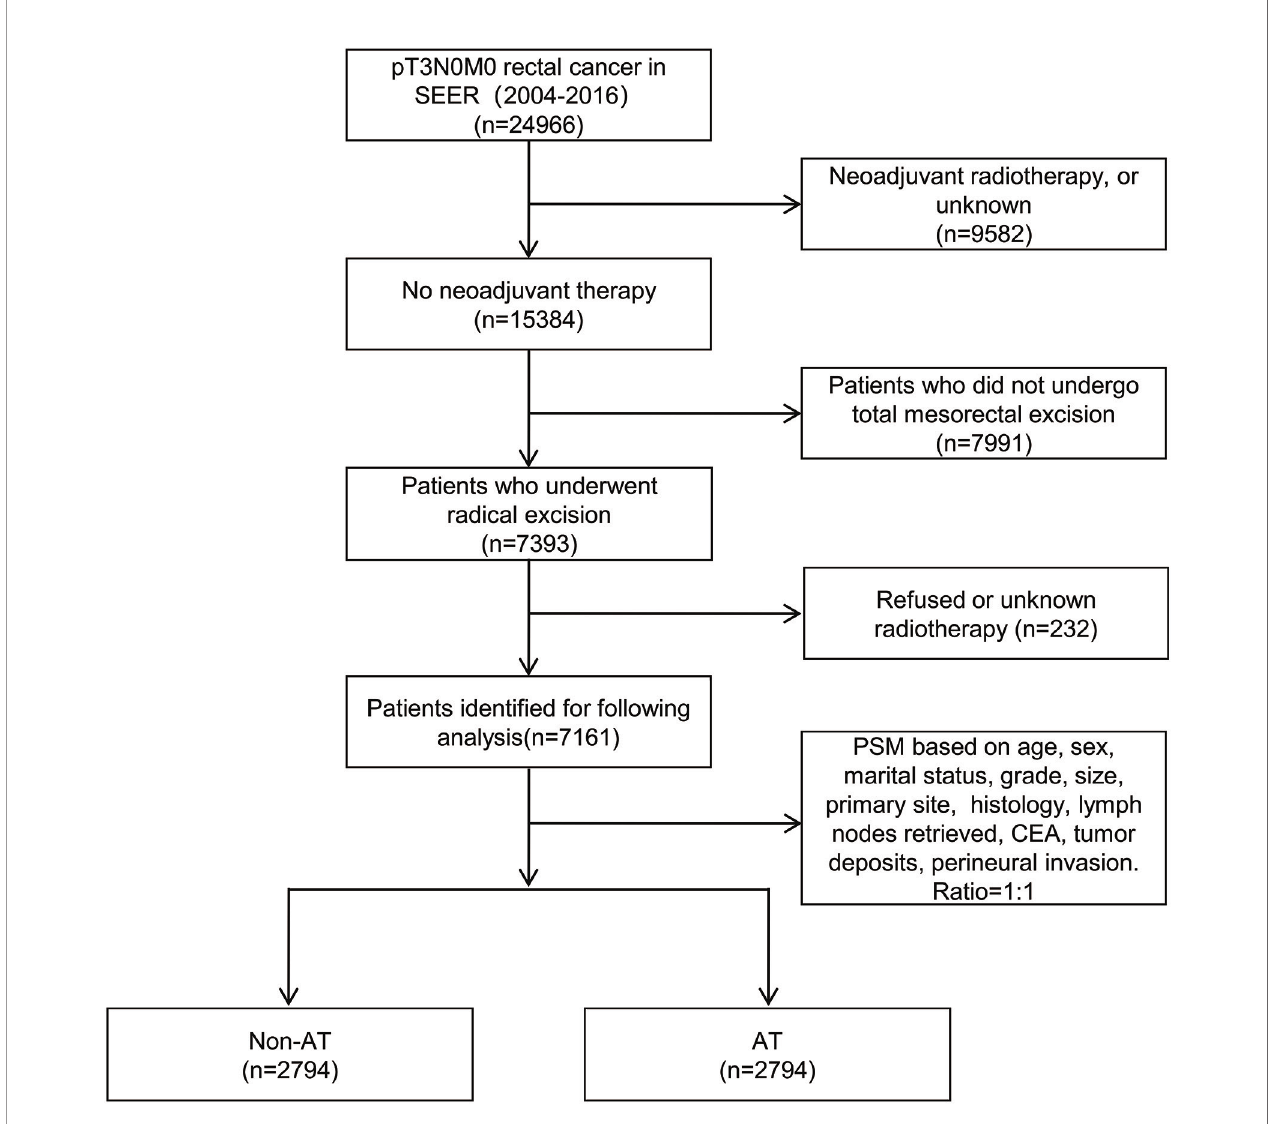
FIGURE 1 | Flowchart of the selection process of included